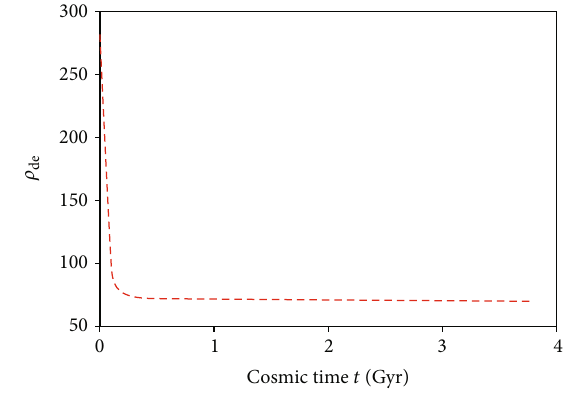
Þ versus cosmic time t de = 1 , respectively. 0